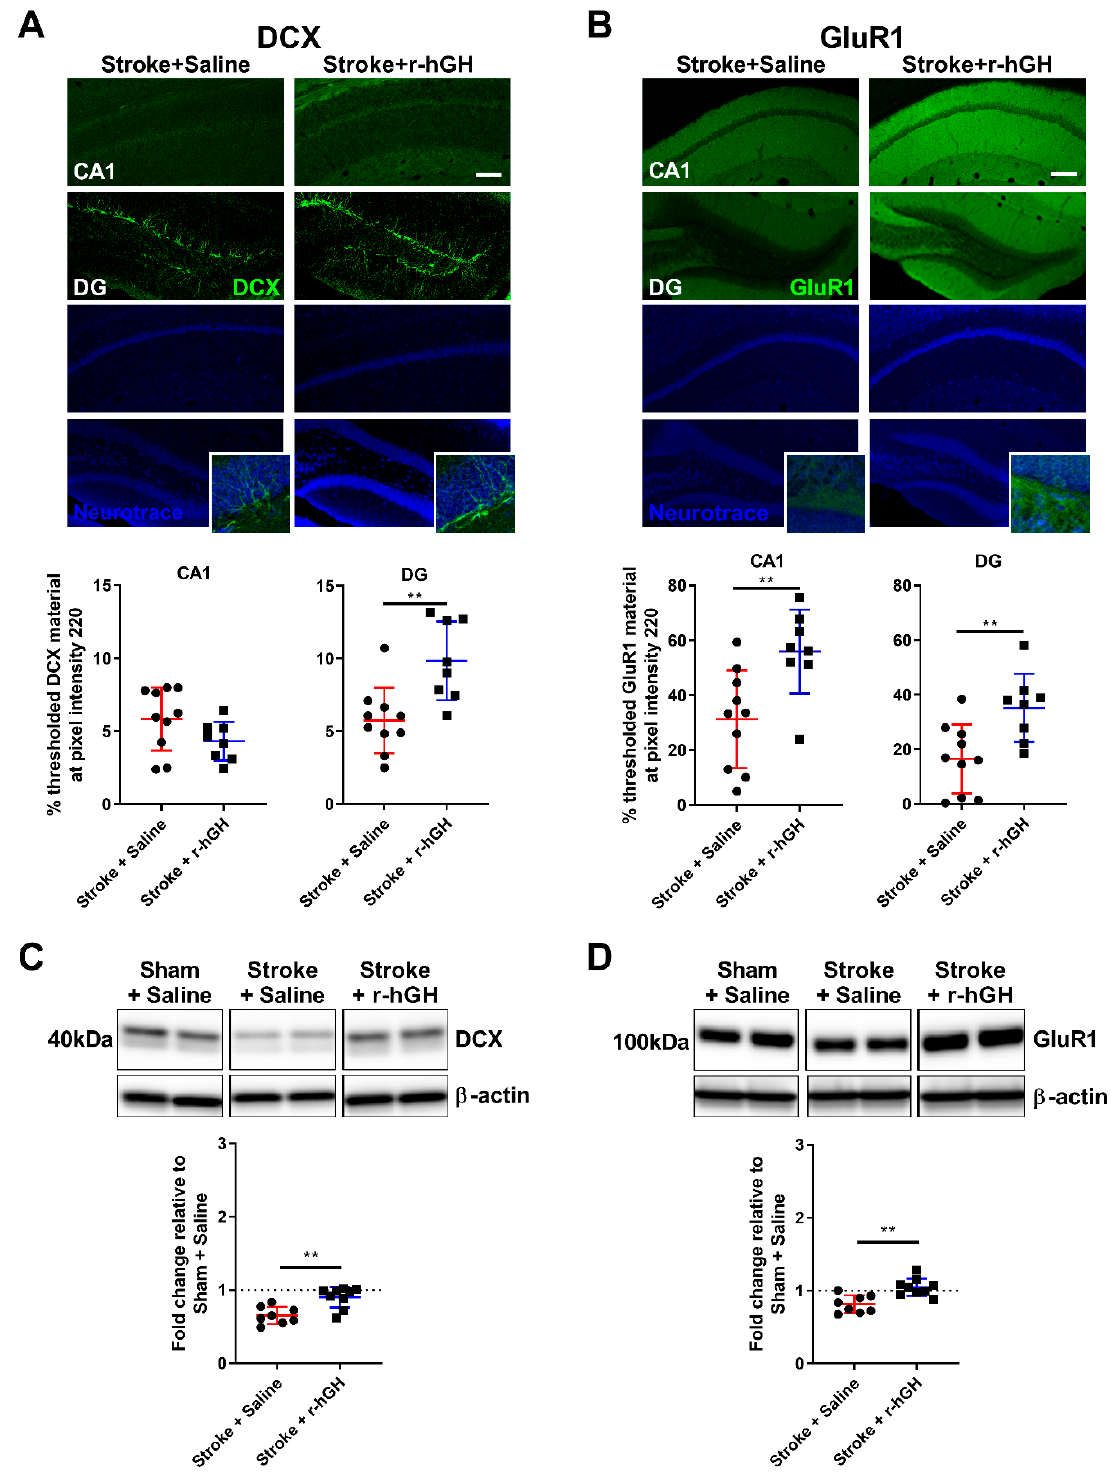
Figure 3. ( A ) Representative immunofluorescence images and quantification of doublecortin (DCX; green) in the CA1 and DG (scale bar = 100 μ m). ( B ) Representative immunofluorescence images and quantification of glutamate receptor 1 (GluR1; green) in the CA1 and DG (scale bar = 100 μ m). ( C and D ) Representative western blot and quantification of DCX and GluR1 protein levels in the hippocampus. For full immunoblots, see Figure S1. Mean ±S D (2-tailed t -test). ** p < 0.01. 2.3. GH Treatment Promotes Expression of GluR1 within the Hippocampal Formation